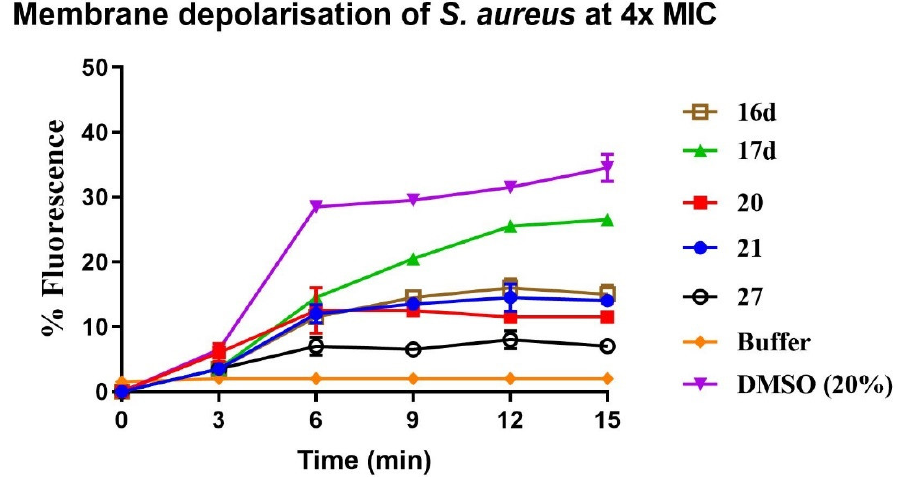
Figure 5. Percentage increase in fluorescence vs. time of membrane depolarisation of S. aureus with compounds 16d, 17c, 17d, 20, 21 and 27 at concentration of 4 × MIC.